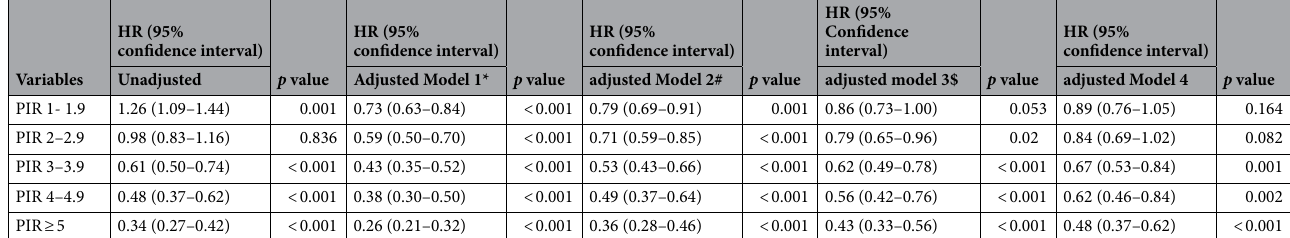
Table 4. Hazard ratios (95% confidence intervals) for the risk of all-cause mortality stratified by PIR Categories. *Models are adjusted for age, sex and race/ethnicity. # Models are adjusted for age, sex, race/ ethnicity, citizen status, marital status, education status and insurance (yes or no, not the types). $ Models are adjusted for age, sex, race/ethnicity, citizen status, marital status, education status and insurance (yes or no, not the types), diabetes mellitus, hypertension, smoker, obesity, dyslipidemia. ¶ Models are adjusted for age, sex, race/ethnicity, citizen status, marital status, education status and insurance (yes or no, not the types), diabetes mellitus, hypertension, smoker, obesity, dyslipidemia, CAD, CHF and stroke.